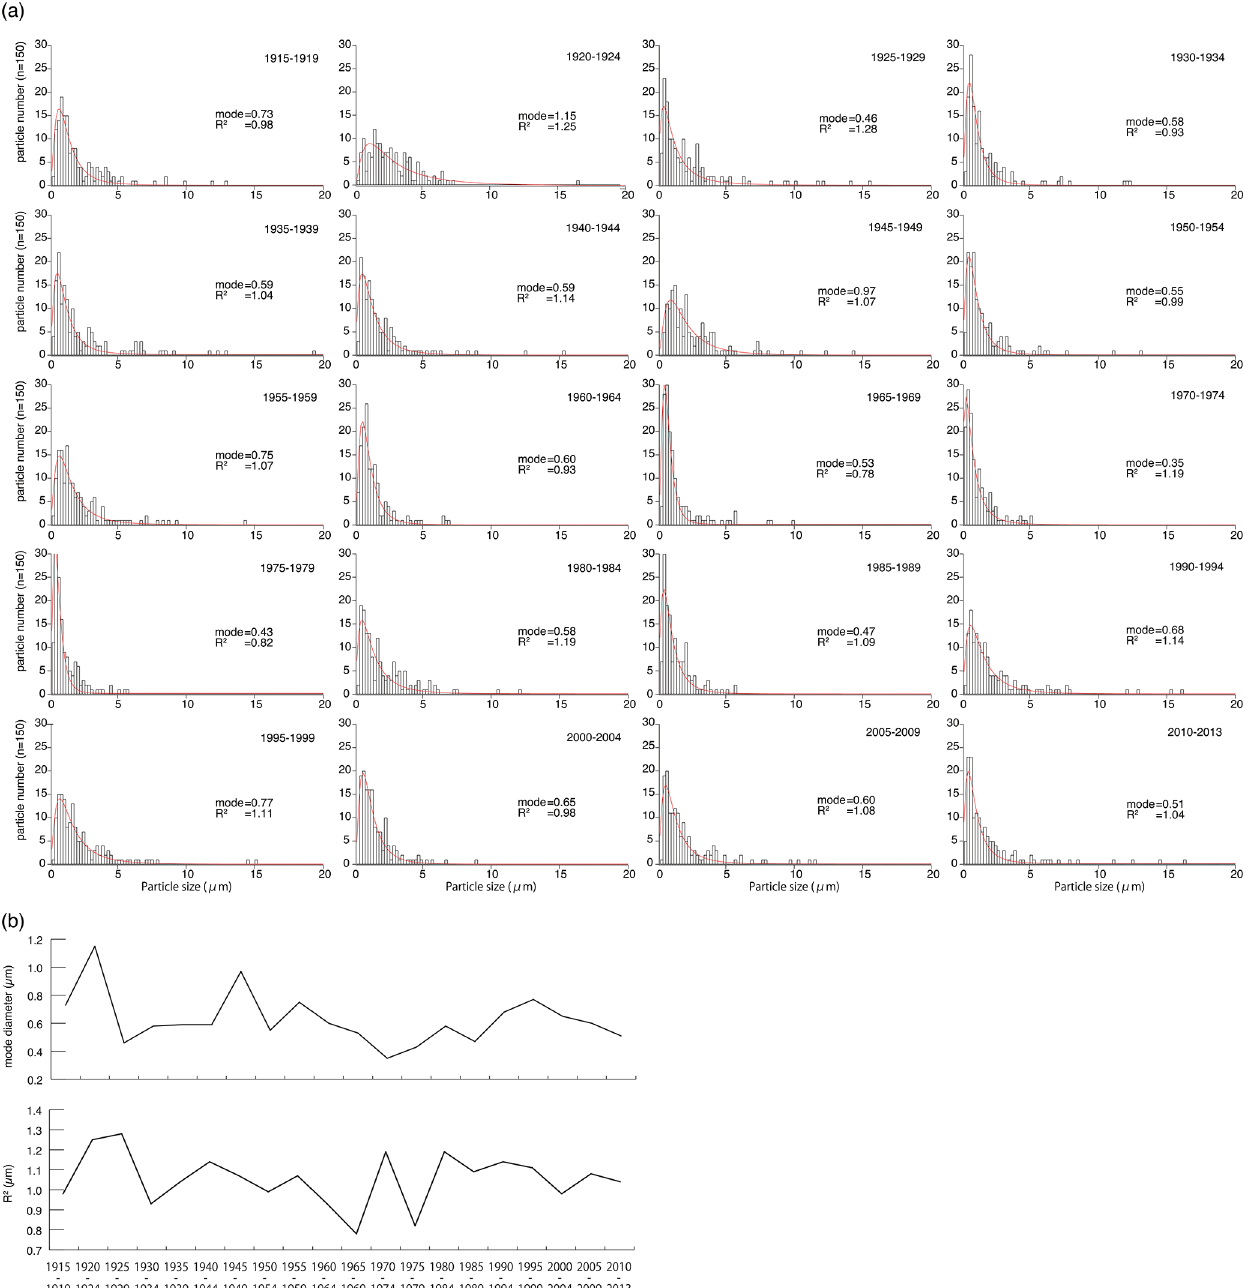
Figure A2. (a) Comparison of particle size distribution and log-normal fitting results (mode: mode diameter and R 2 : half peak width) of the ice core minerals among the samples. (b) Historical changes in the mode diameter and R 2